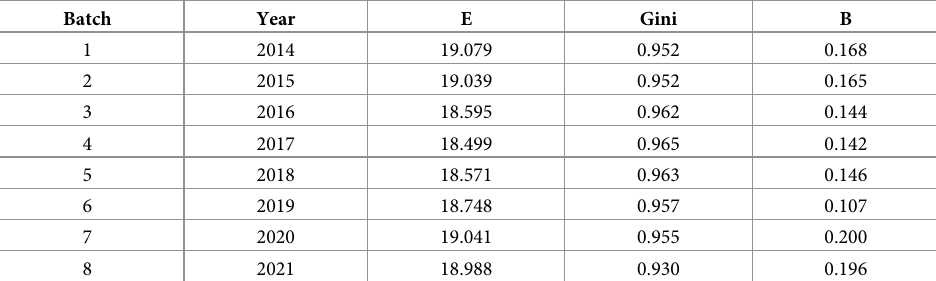
Table 3. Geographic concentrate index, Gini coefficient and unbalanced index of beautiful leisure villages distribution.